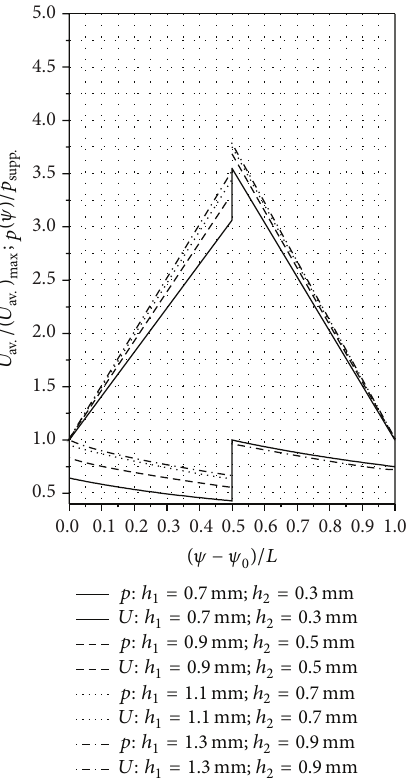
Figure 9: Pressure and speed distributions in the SATBESPIG with external pumping.